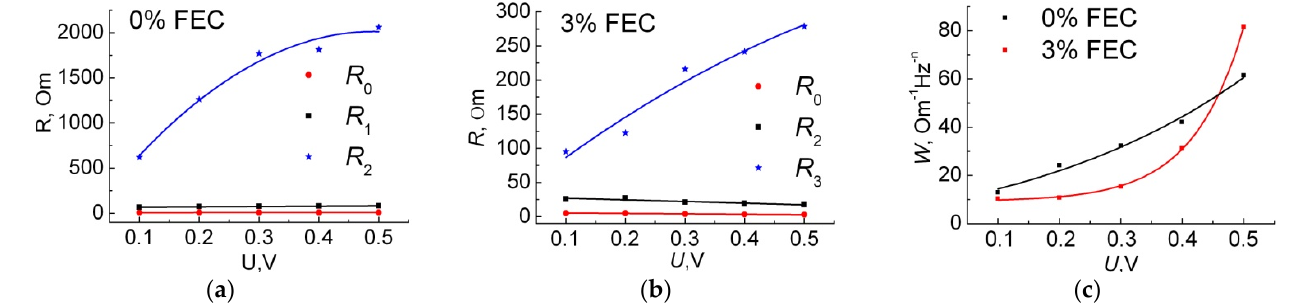
Figure 10. Dependences of fitting parameters R 0 , R 1 and R 2 on voltage for sample with 0% ( a ) and 3% ( b ) FEC, as well as dependence on voltage of Warburg coefficient W ( c ).